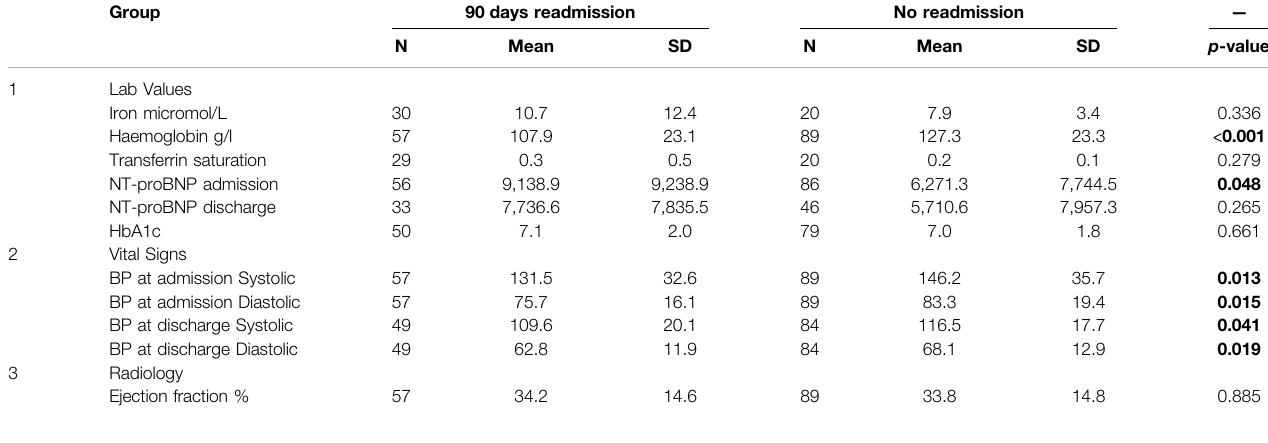
TABLE 8 | Lab values, radiology and vital signs among readmission and